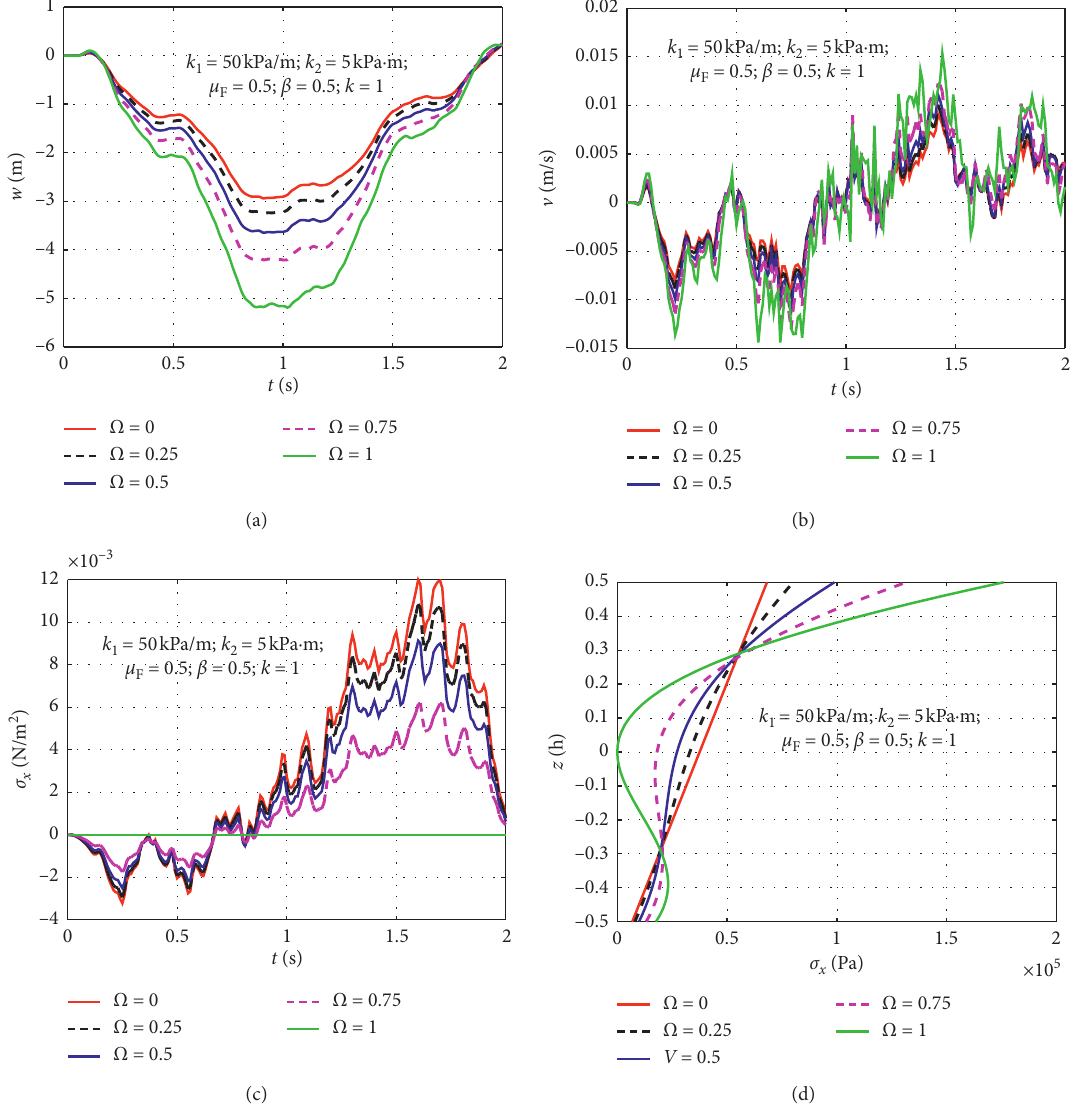
Figure 14: The responses of deflections, velocities, and stresses at the central point of the FGP plate versus time with the variation of the porosity distribution Ω : (a) deflection w versus time; (b) velocity v versus time; (c) stress σ x versus time; (d) stress σ x through thickness. Table 9: Maximum deflections, velocities, and stresses at the central point of the FGP plate versus time ( Ω � 0 . 5). Maximum values